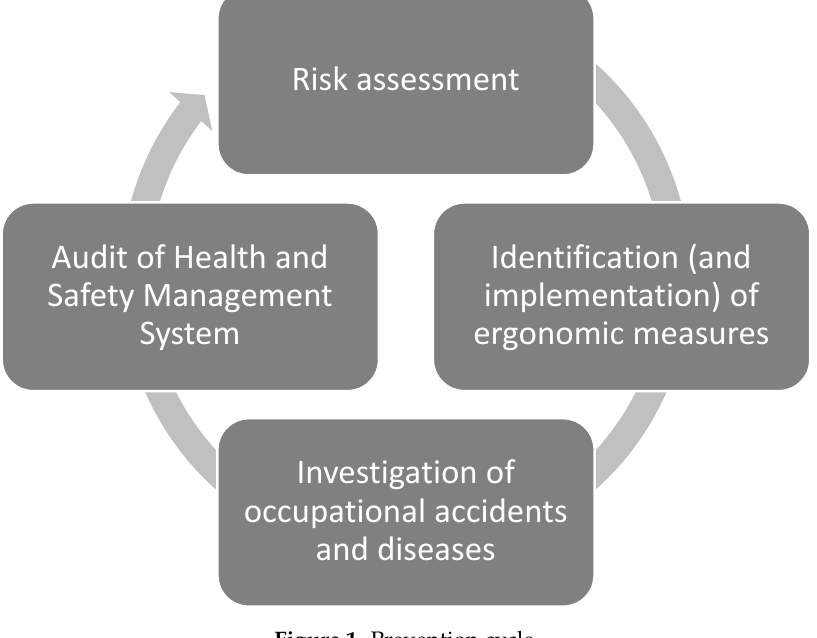
Figure 1. Prevention cycle.